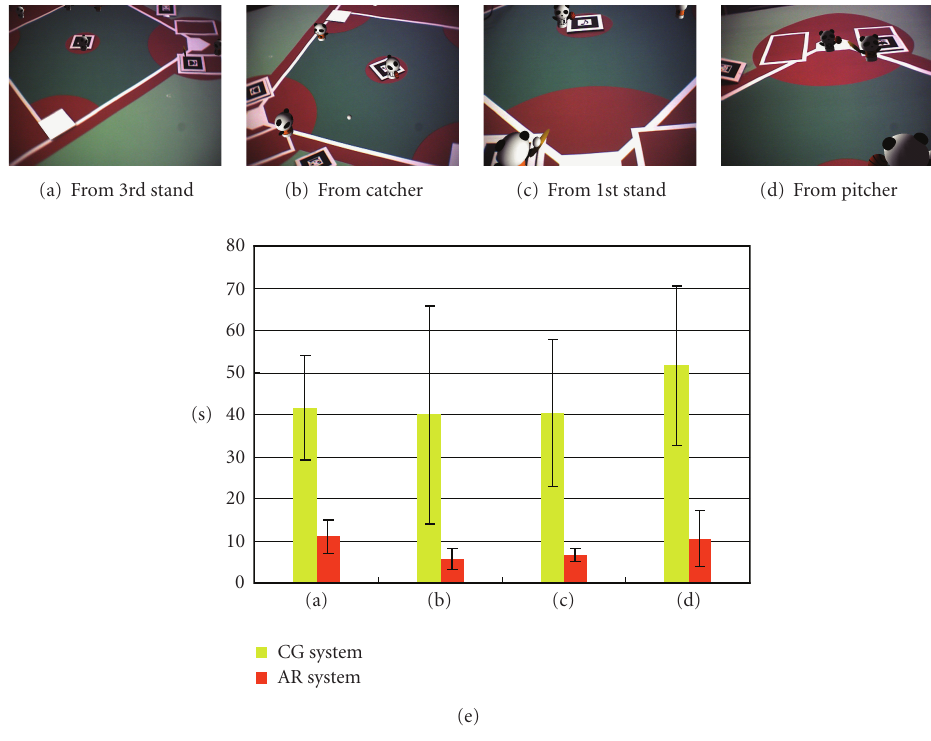
Figure 21: Average time the examinees took to change their view points to specified view points.